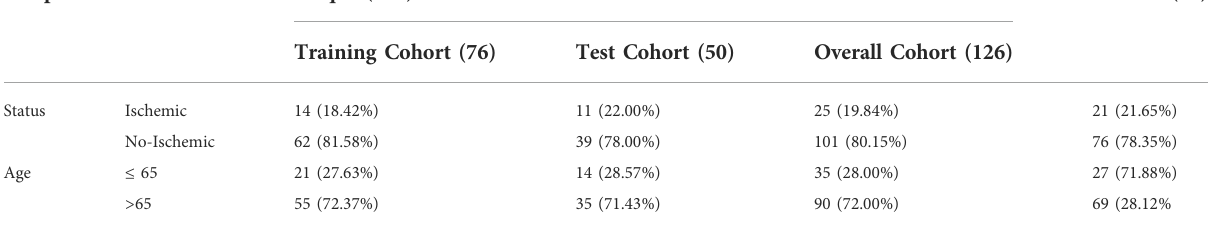
TABLE 1 Detailed information of GSE21545